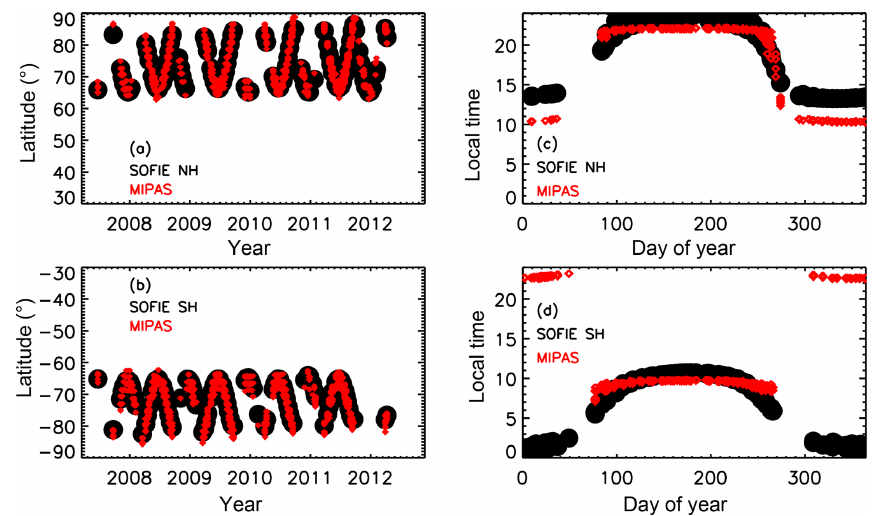
Figure 6. Summary of SOFIE–MIPAS coincidences. Measurement latitude vs. year in the (a) NH (SOFIE sunrise; local sunset) and (b) SH (SOFIE sunset; local sunrise). Measurement LT versus day of year in the (c) NH and (d) SH. The NH had 894 coincidences with average separations of 0.9h, 1.3 ◦ latitude, and 9.6 ◦ longitude. The SH had 985 coincidences with average separations of 0.8h, 1.4 ◦ latitude, and 8.7 ◦ longitude. Note that the MIPAS solar zenith angles ranged from 82 to 95 ◦ for the SH SOFIE comparisons and from 84 to 94 ◦ for the NH comparisons, which is near local sunrise (or